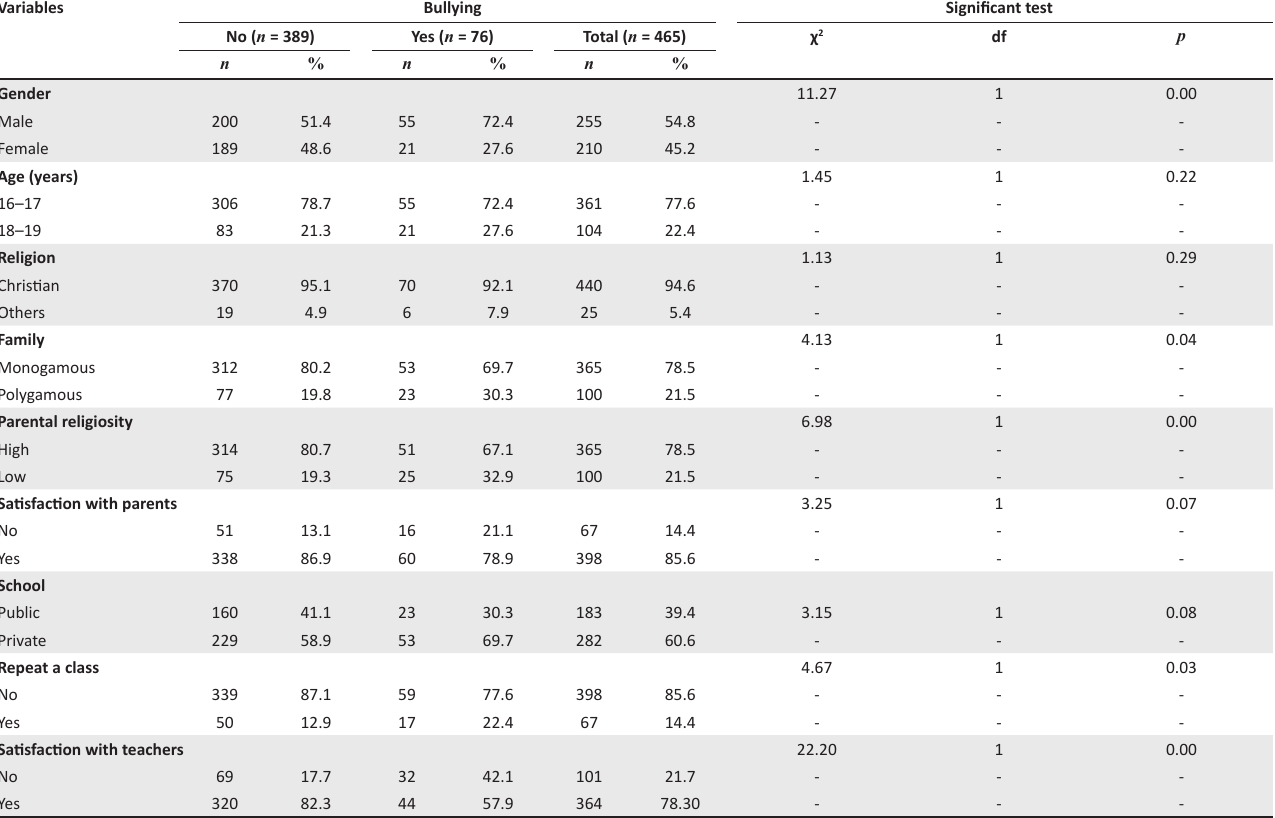
TABLE 1: Association of bullying with demographics, family and school-related factors.